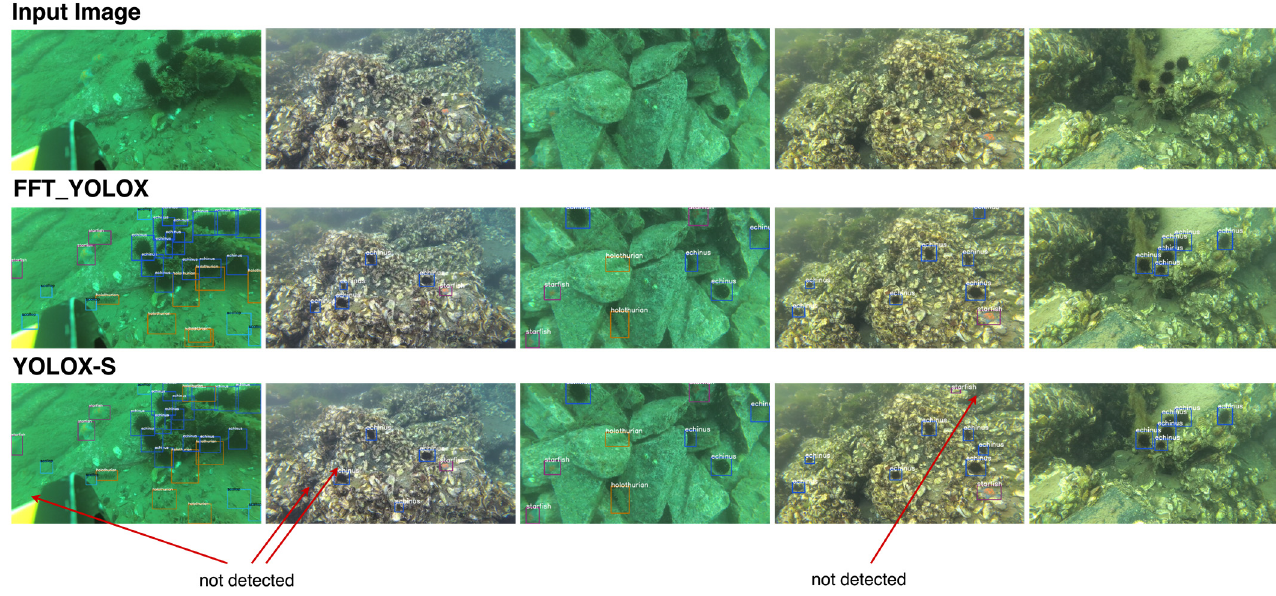
Figure 3. The detection results of FFT_YOLOX model.